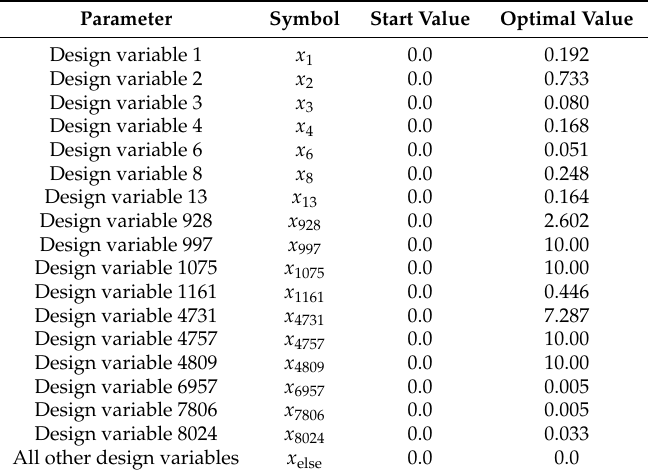
Table 5. Optimal values of the design variables for the gear housing, all values in